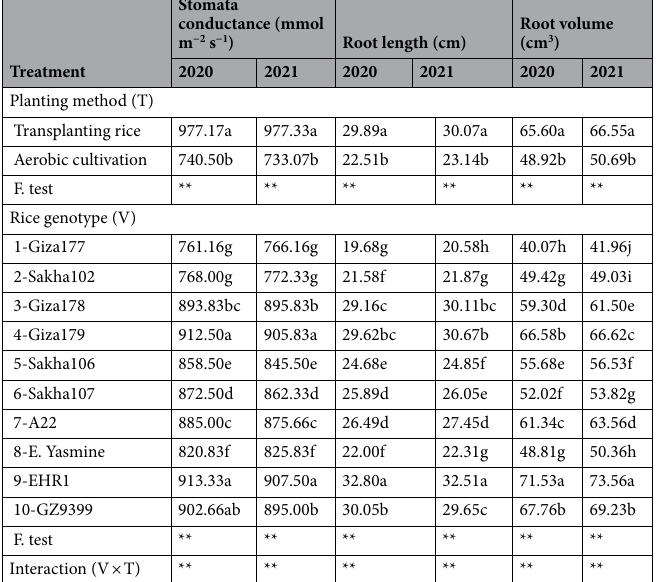
Table 9. Stomata conductance, root length and root volume of some rice genotypes affected by the planting methods. **Significant at 0.01 level. Means followed by a common letter at the same column are not significantly different according to Duncan ’ s multiple range at 0.05